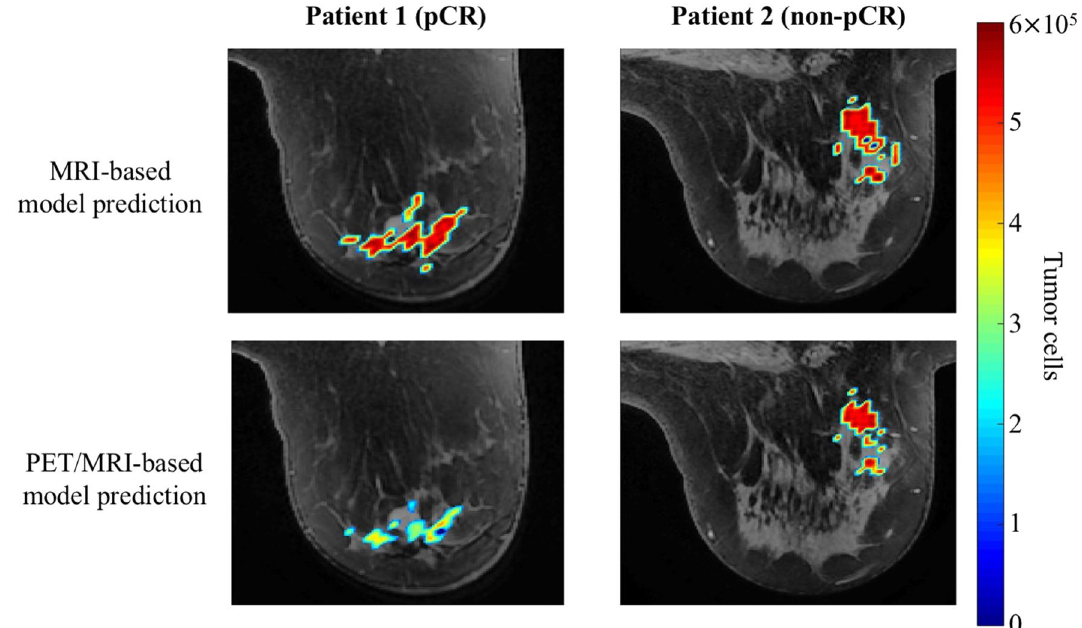
Figure 5. Central slice examples of the predicted tumor cellularity by the MRI-based model compared to the PET/MRI-based model. The number of tumor cells is overlaid (color) on an anatomical image of the breast (grey). At surgery patient 1 ′ s (left column) tumor response was designated as pCR and for patient 2 (right column) the tumor response was designated as non-pCR. Notice that the PET/MRI-based model predicts overall smaller tumors and for patient 1 specifically, lower overall cellularity.